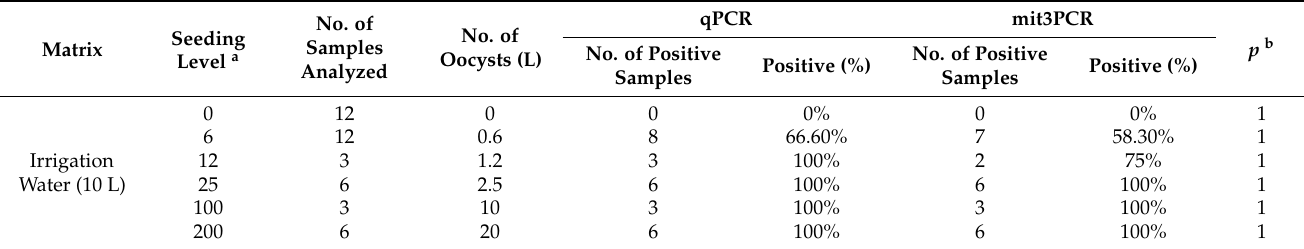
Table 3. Summary of detection of C. cayetanensis in seeded and unseeded agricultural water using DEUF combined with qPCR and